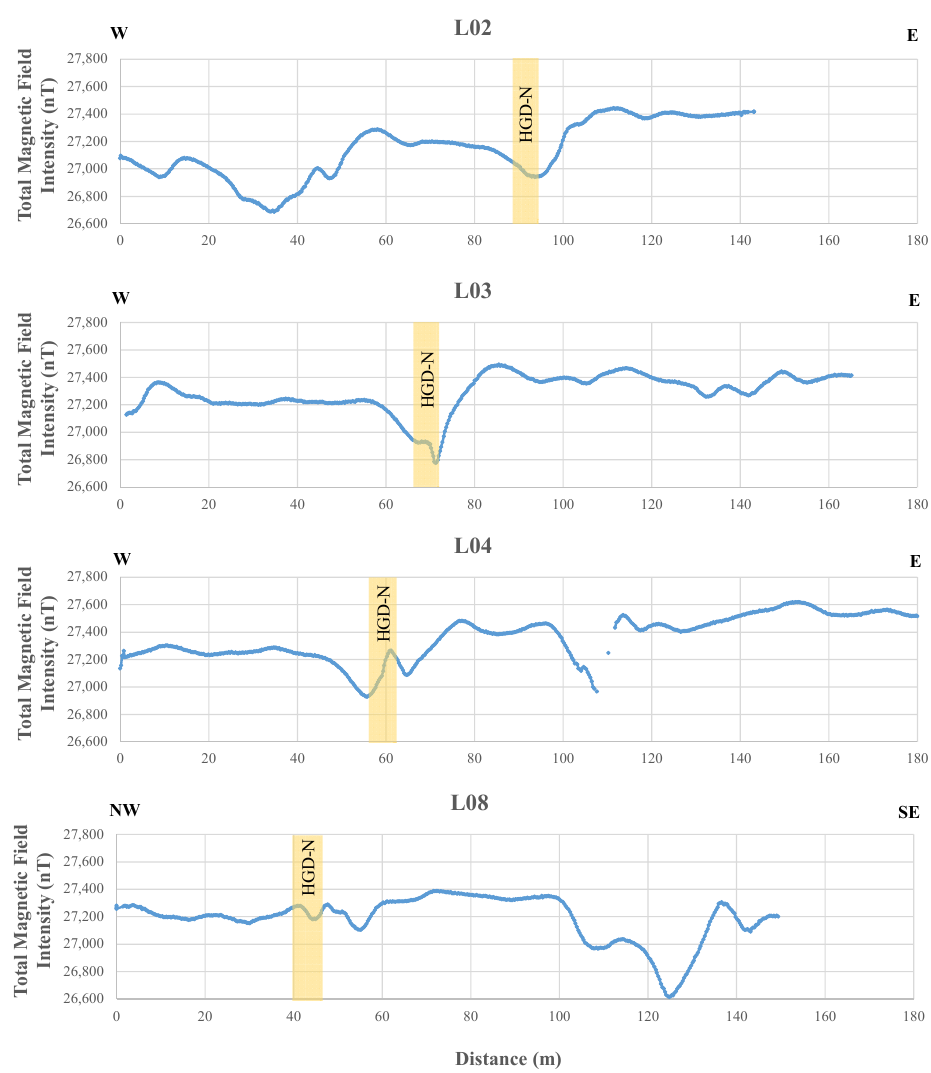
Figure 5. Profile plots of the total magnetic field recorded along the lines L02, L03, L04, and L08. A contour map of the total magnetic field recorded across HGD-N is shown in Figure